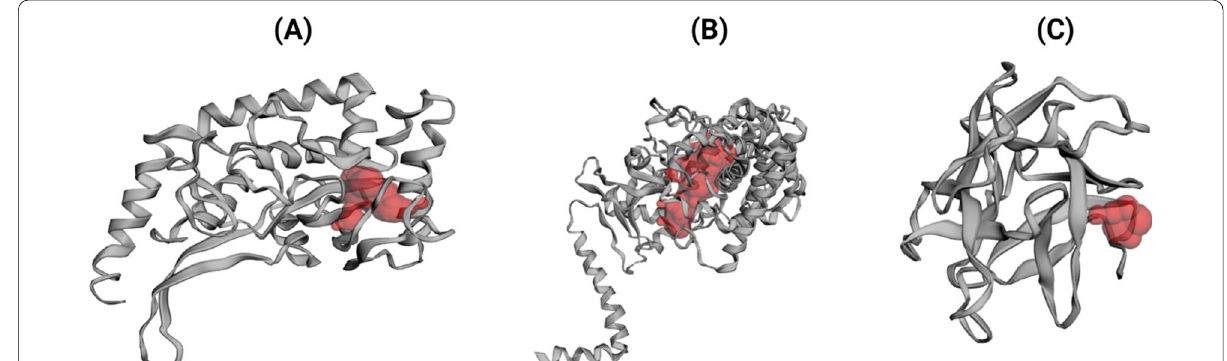
Fig. 4 Predicted ligand-binding pockets of CotH3 ( a ), lanosterol 14 alpha-demethylase ( b ), mucoricin ( c ) via CASTp server